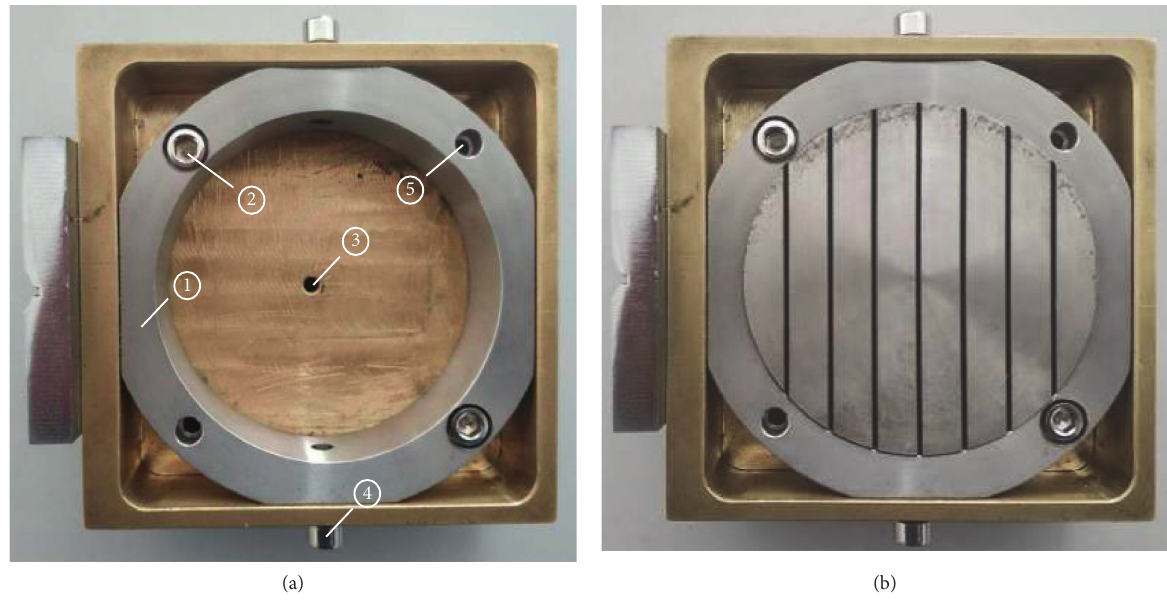
Figure 2: (a) ① Steel ring; ② connecting bolts for fixing the steel ring and lower shear box; ③ circular hole at the bottom of the lower box; ④ bolts for fixing the structure in the lower box; ⑤ bolt hole for connecting the upper shear box. (b) Lower shear box for direct shear apparatus.